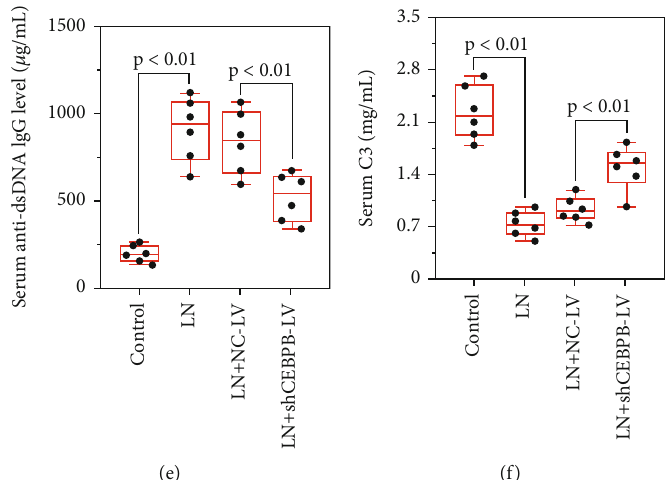
Figure 2: The knockdown of CEBPB alleviated the kidney damage in MRL/lpr mice. The mRNA and protein expression of CEBPB (a); 24- hour proteinuria level (b), serum BUN level (c), serum creatinine level (d), serum anti-dsDNA IgG level (e), and serum complement C3 level (f) in MRL/lpr mice injected with sh CEBPB lentivirus. (CEBPB, CCAAT/enhancer-binding protein β ; sh CEBPB , CEBPB -short hairpin RNA; BUN, blood urea nitrogen).